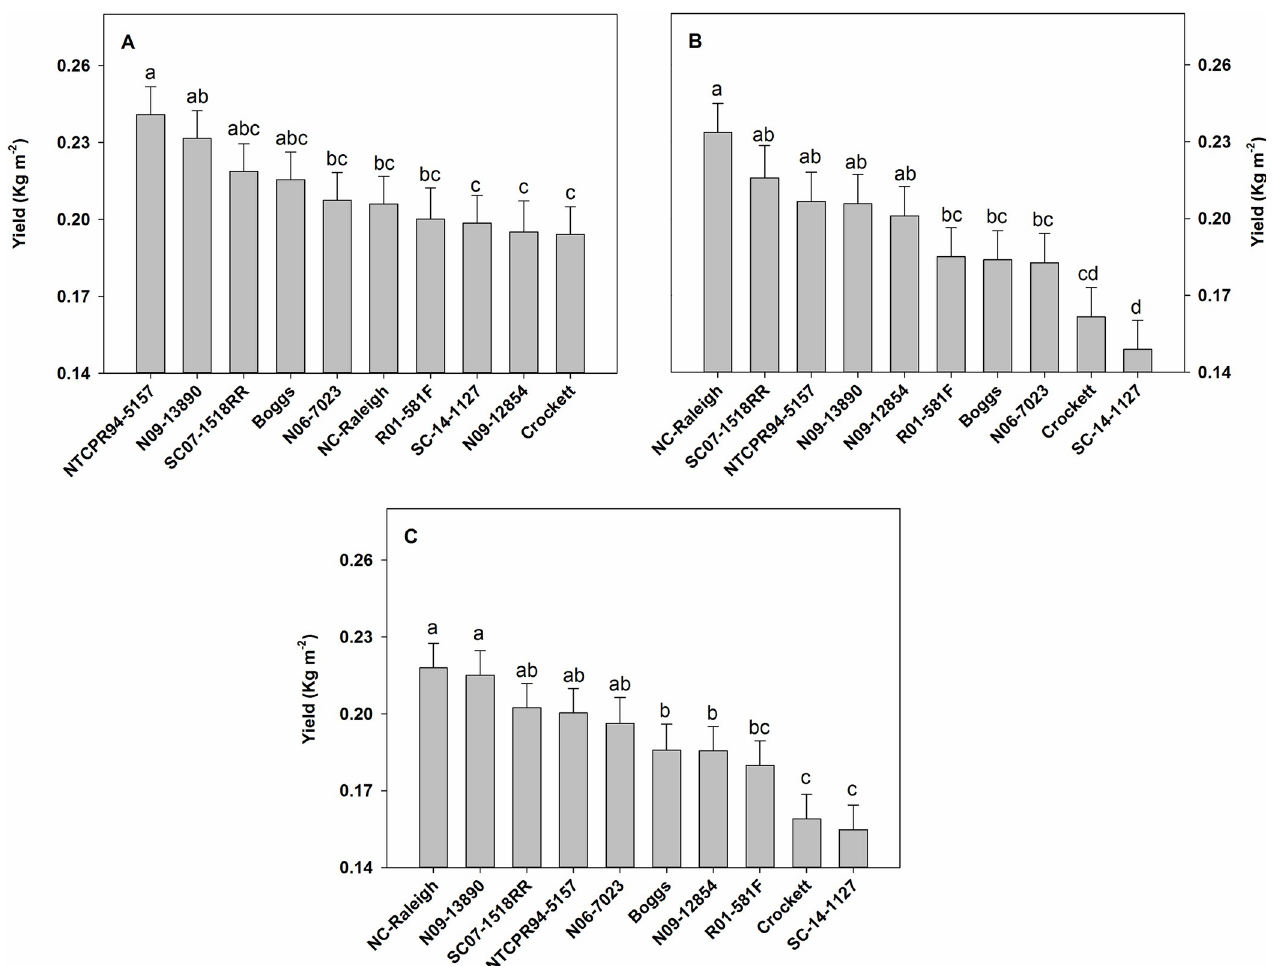
Fig 4. Seed yield of soybean genotypes grown at Florence, SC, USA under irrigated and non-irrigated conditions (Fig a and b, respectively) and at Pendleton, SC, USA (Fig c). Irrigated plots received 25.4 mm water at 35, 56, 69, 76, and 83 days after planting (DAP) at Florence and 25.4 mm water at 102 DAP at Pendleton. However, the genotype-by-irrigation interaction effect was not significant on yield at Pendleton. Therefore, data were averaged across irrigation treatments for this location. Bars represent least square means and error bars represent standard errors. Least square means with different letters are significantly different according to the LSD test at P <